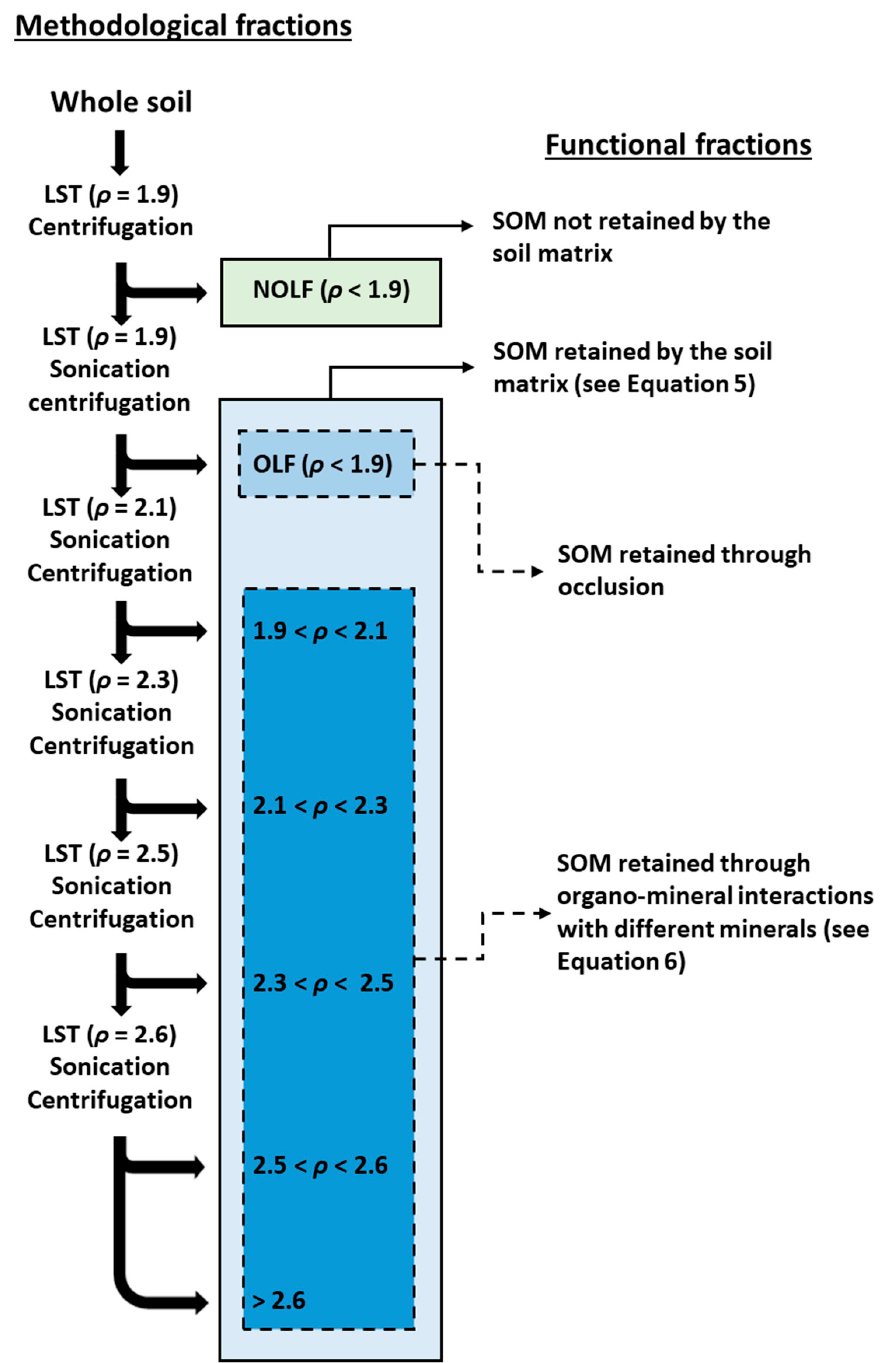
Figure 1. Fractionation scheme illustrating the methodological procedure and presumed functionality of soil organic